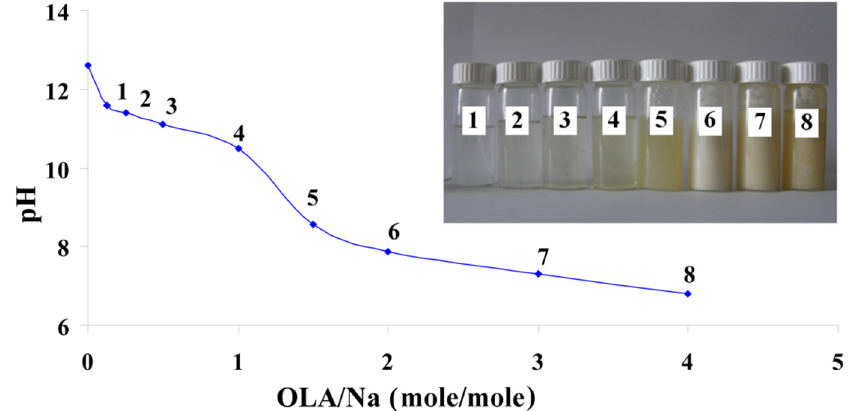
Figure 1. pH modification of the dispersions prepared at a fixed amount of sodium silicate and different quantities of oleic acid (OLA); Inset Picture : The dispersions prepared at different quantities of OLA and a fixed amount of sodium silicate ( 1. 0.125/1; 2. 0.25/1; 3. 0.5/1; 4. 1/1; 5. 1.5/1; 6. 2/1; 7. 3/1 and 8. 4/1 OLA/Na).